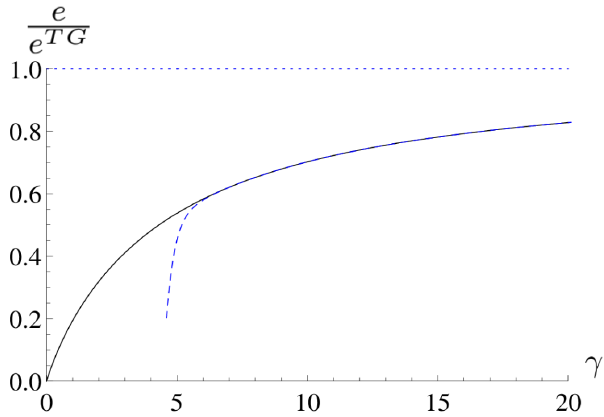
Figure 15: Ground state energy per particle e in units of its value in the Tonks-Girardeau limit e TG , as a function of the dimensionless interaction strength γ . Numerically exact result (black), compared to 20 th -order expansion in the strongly-interacting regime (blue, dashed) as given by Eq. (104). The value in the Tonks-Girardeau limit (horizontal, blue, dotted) is also indicated on the